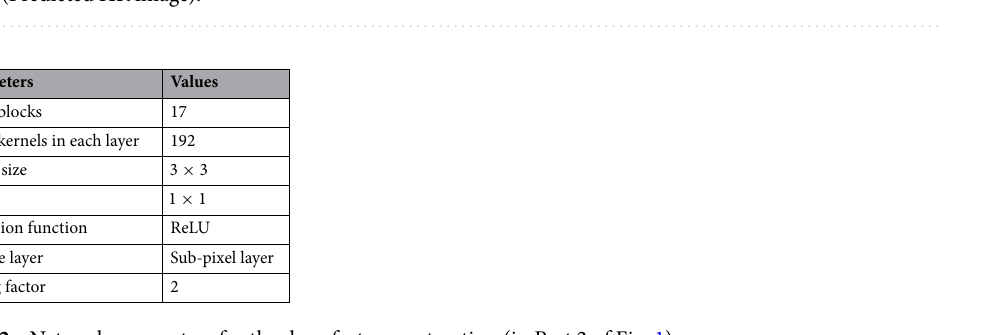
Table 2. Network parameters for the deep features extraction (in Part 2 of Fig. 1).